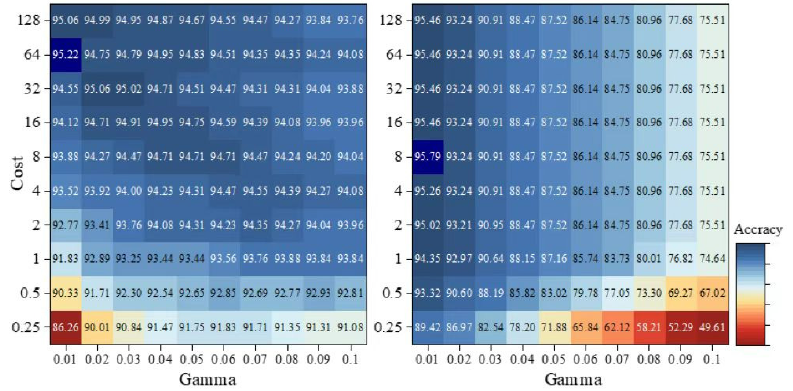
Figure A2. Hyperparameter grid search of SVM in pixel-based ( right ) and object-based ( left ) classification methods under optimal feature combination.